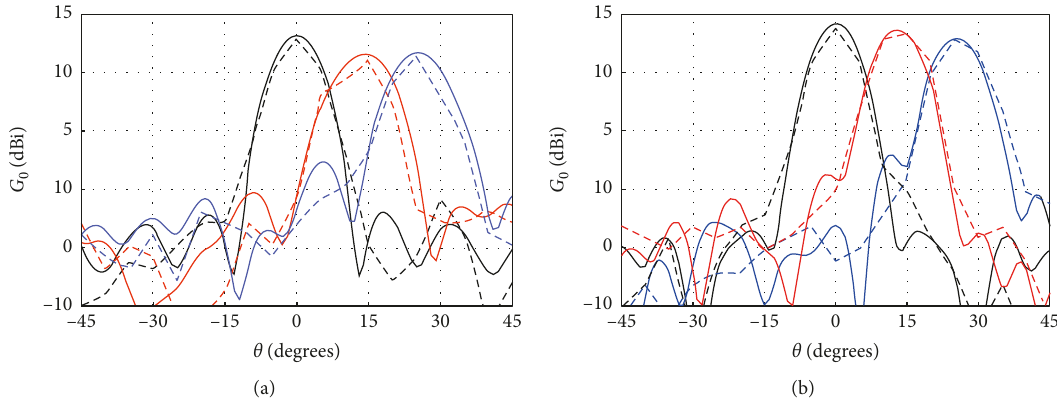
Figure 10: Ultra-wideband dielectric lens antennas for beamsteering system radiation pattern. A A 2 simulation, A 2 measurement, A 3 simulation, A 3 measurement. (a) f � 8GHz; (b) f �